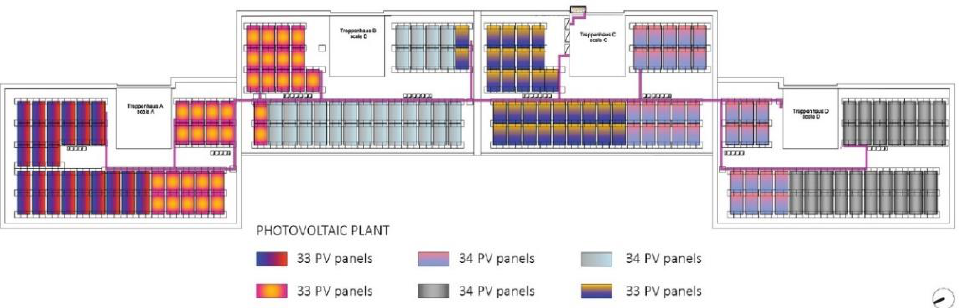
Figure 8. Technical plan of PV system on the roof of the north building (source: © EQ Ingegneria).